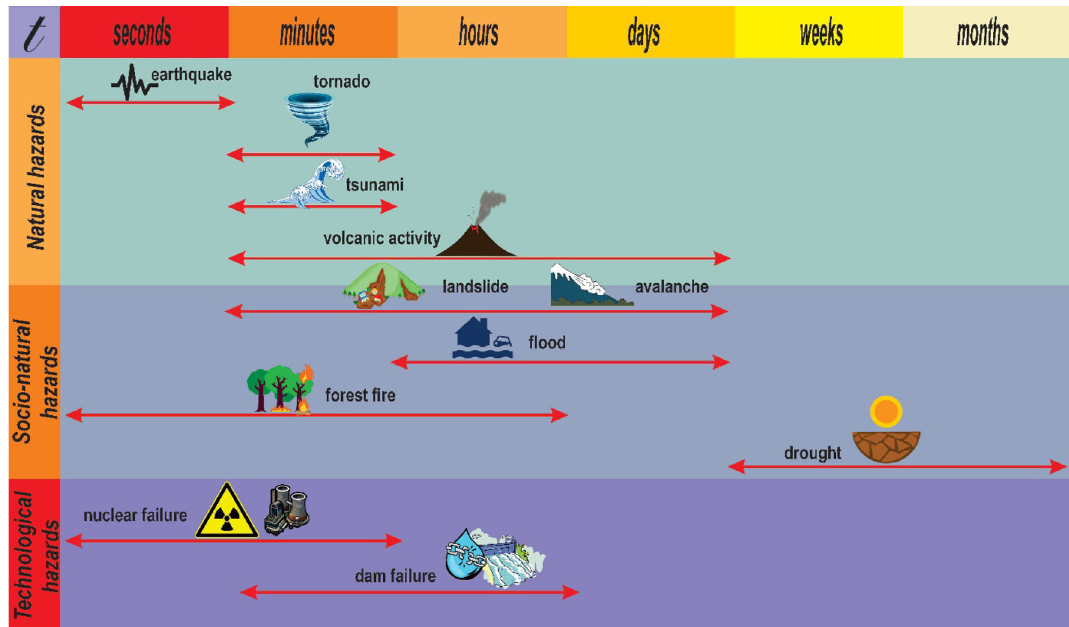
Fig. 3 Speed of hazard onset according to hazard typology from a physicalist-centered perspective. Early warning systems, as originally defined by famine early warning systems, were characterized by a long-term perspective and analysis of the occurrence of